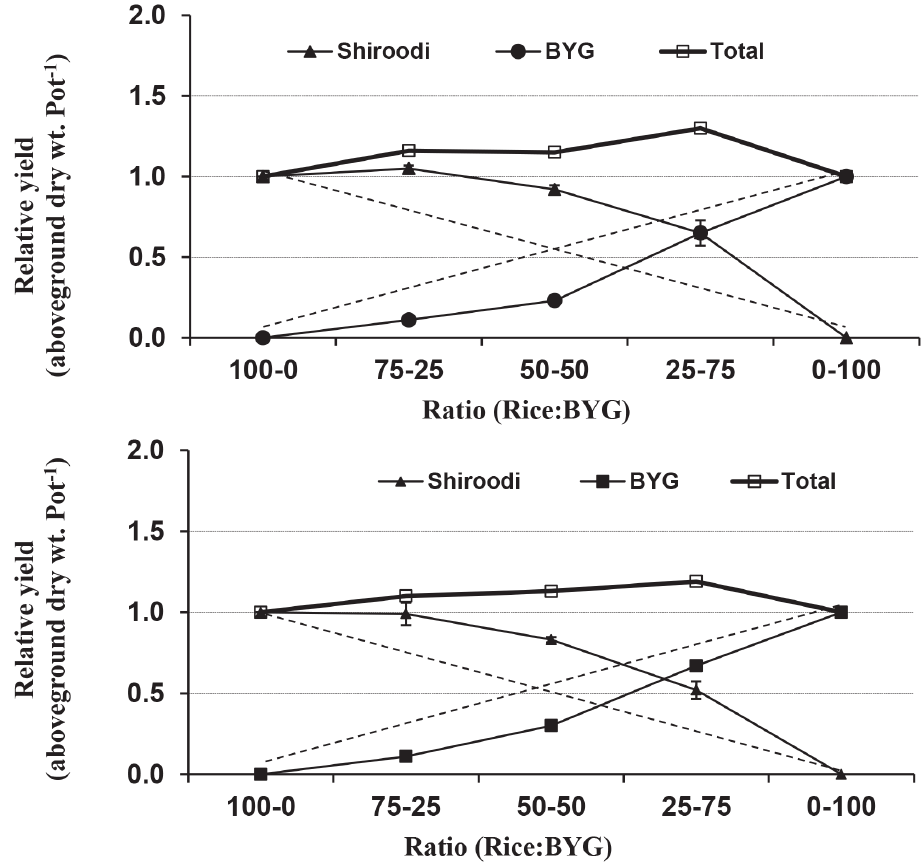
Figure 3 - Relative aboveground dry weights of rice ‘cv. Shiroudi’ (▲), barnyardgrass (BYG) (●) and relative yield totals (RYT) (□) as influenced by methanol foliar application [above: methanol was not sprayed, and below: methanol sprayed at 14% (v/v)] and rice: BYG ratios in a replacement series over two years. The two straight dashed lines in each frame indicate the theoretically expected responses for two equally competitive species, which intersect at the point of equivalency (Harper 1977). Error bars represent ± standard errors of the